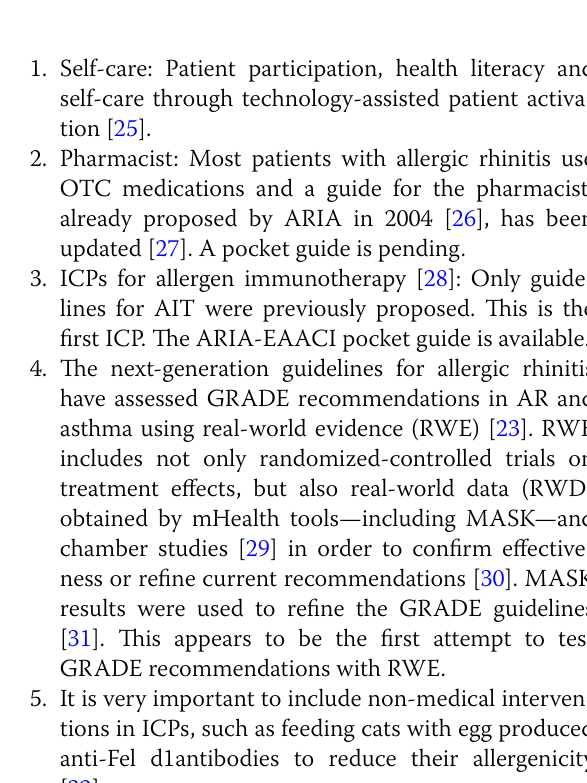
Fig. 1 Next‑generation care pathways integrating Planetary Health sustainability (from